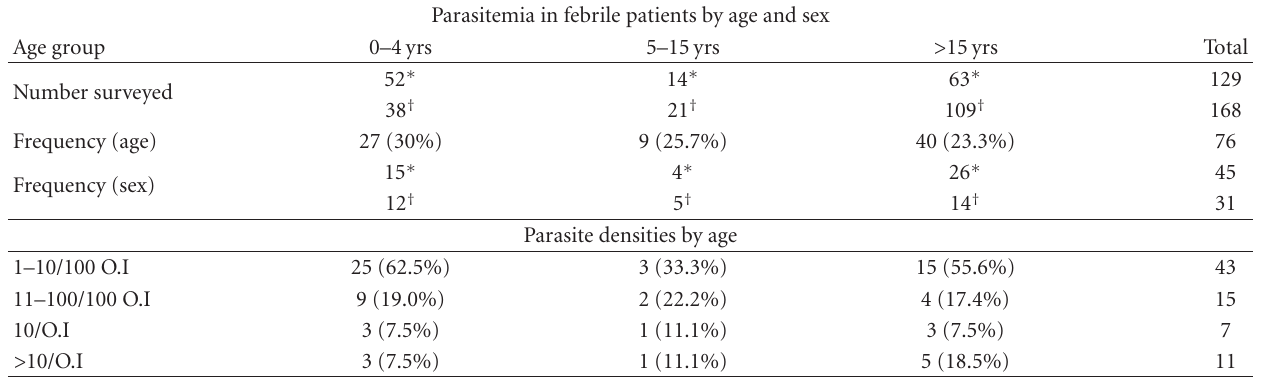
Table 2: Parasitological survey